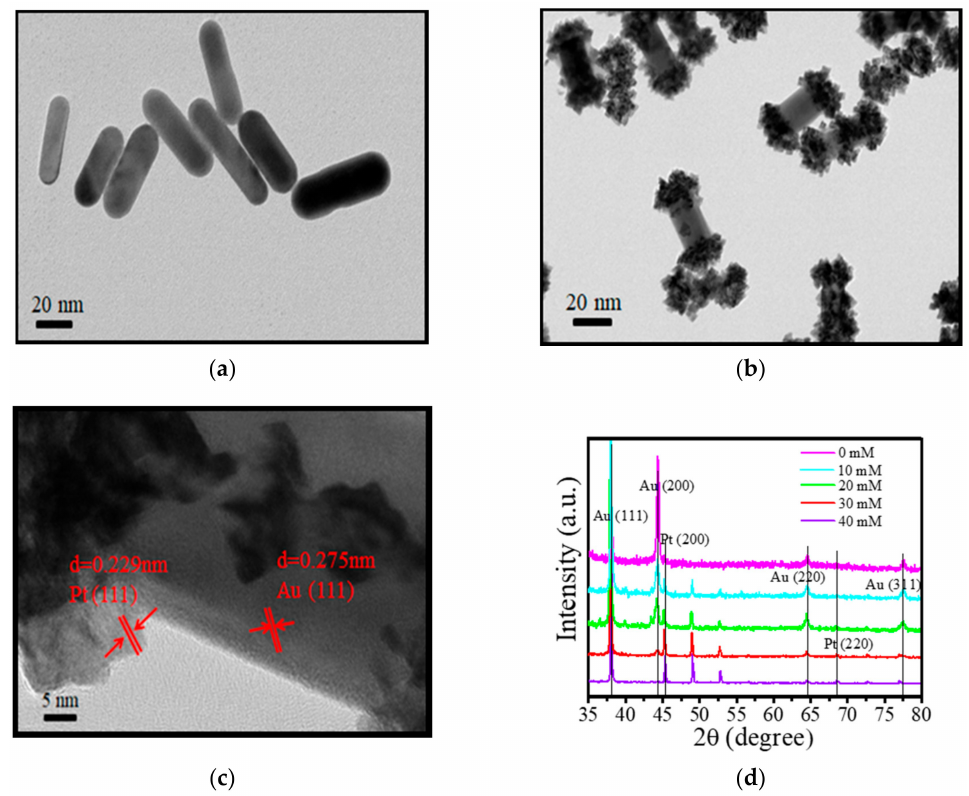
Figure 1. TEM images of ( a ) Au nanorods (NRs) and ( b ) Au-tipped Pt NRs. ( c ) HRTEM images of Au-tipped Pt NRs. ( d ) XRD of Au NRs and Au-tipped Pt NRs. The concentrations of Pt were 10, 20, 30 and 40